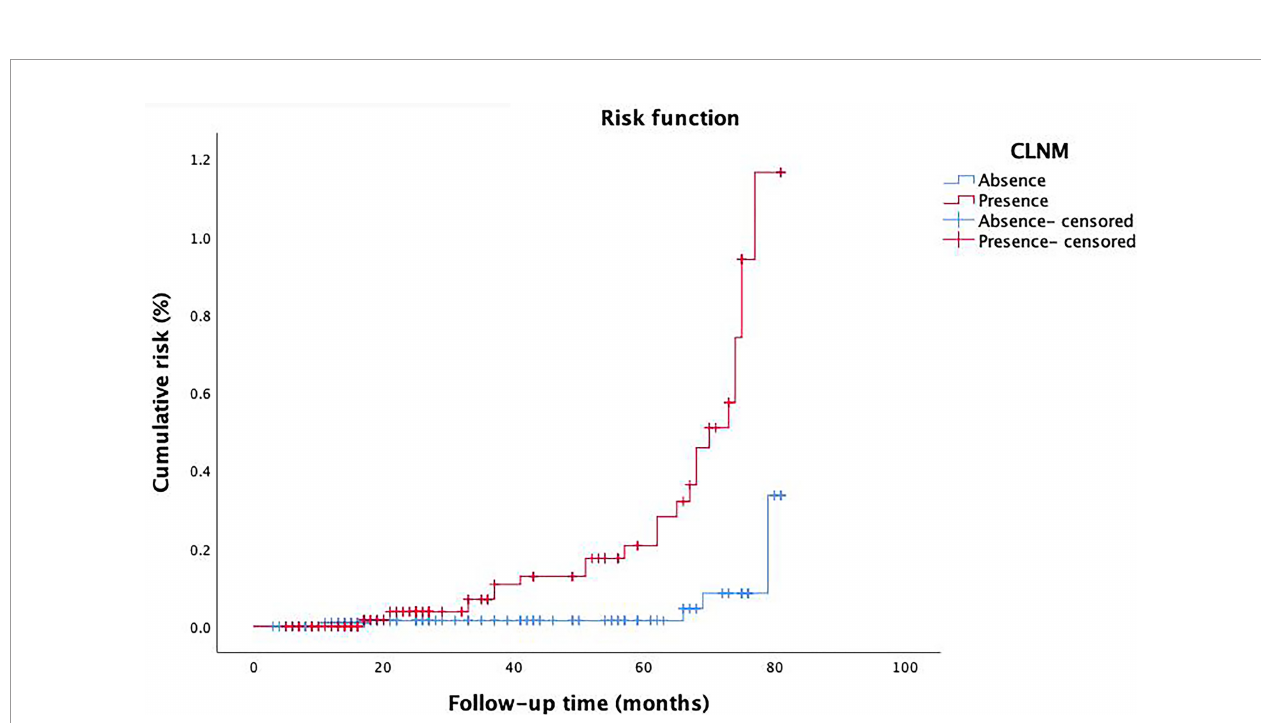
FIGURE 4 | Calibration curve of the model. The diagonal dashed line represents the ideal prediction by the perfect nomogram; the solid line represents the calibration estimate from internally validated model; the dotted line indicates the apparent predictive accuracy. The closer the solid line is to the dotted line, the stronger the predictive ability of the model.